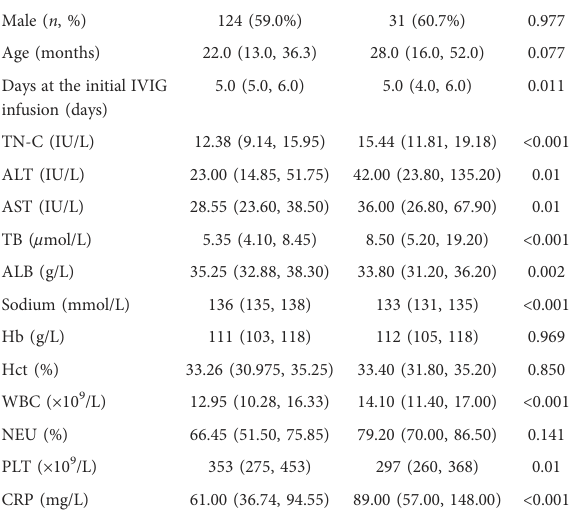
TABLE 1 Comparison of clinical and laboratory characteristics between the IVIG+and IVIG- KD patients.